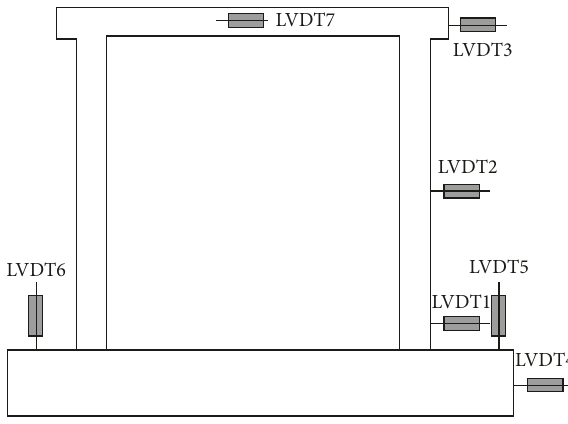
Figure 7: Displacement (LVDTs) plan